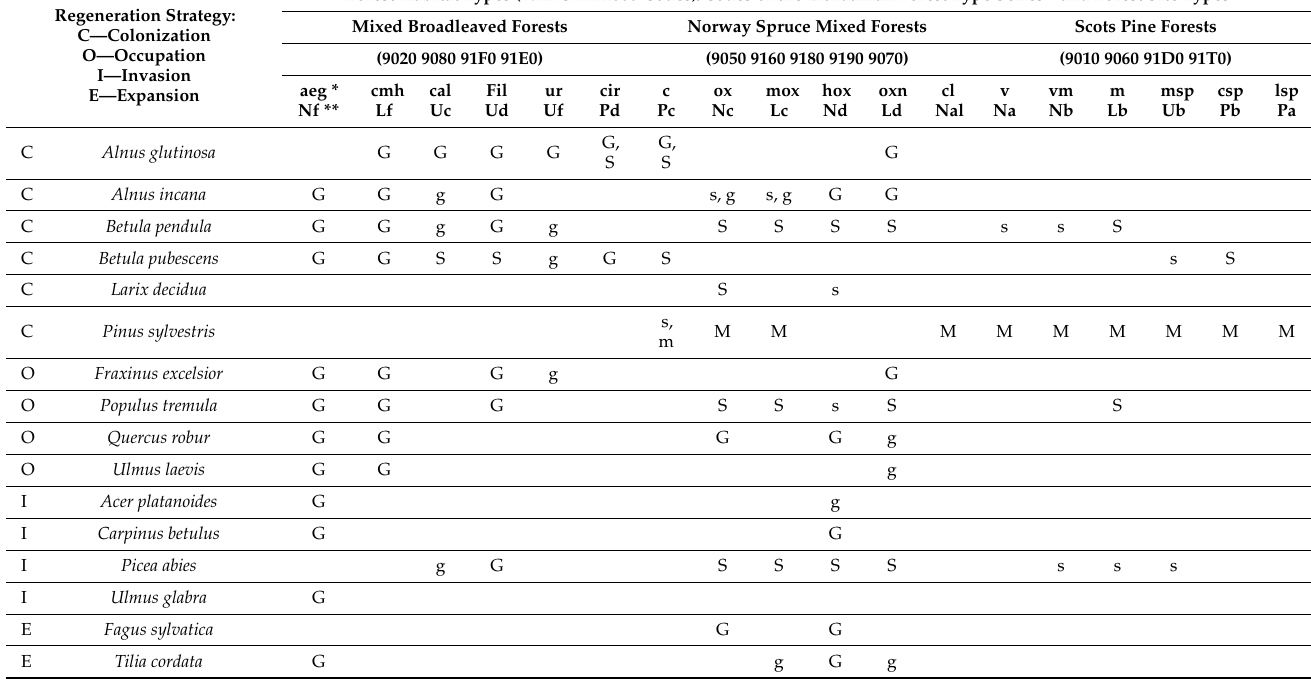
Table 1. Conceptual framework of hemiboreal tree dynamics in Lithuania [32,48,50]. Capital letters indicate the main tree species that form forest stands in gap dynamics (G), successional development (S), or multi-cohort succession (M), whereas small letters (g, s, and m) indicate secondary ones which are a valuable admixture in these